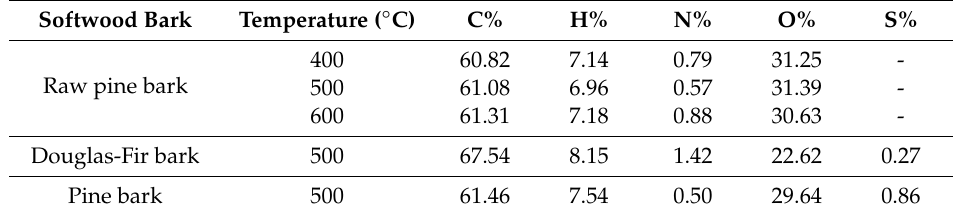
Table 5. Elemental analysis of pyrolysis oil produced from raw pine bark, pine and Douglas-Fir bark. Softwood Bark